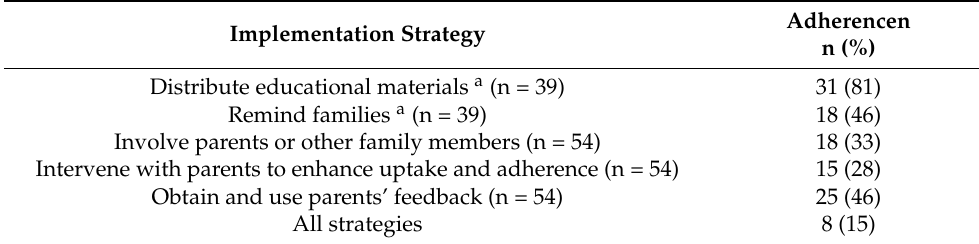
Figure 1. Acceptability, appropriateness, and feasibility ratings of Healthy Me , Healthy We by early care and education (ECE) providers (n = 57) and parents (n = 114) in the enhanced implementation group. Differences in proportion of responses by providers and parents all statistically significant at p < 0.001. Table 6. Early care and education providers’ fidelity to the enhanced implementation approach for Healthy Me , Healthy We